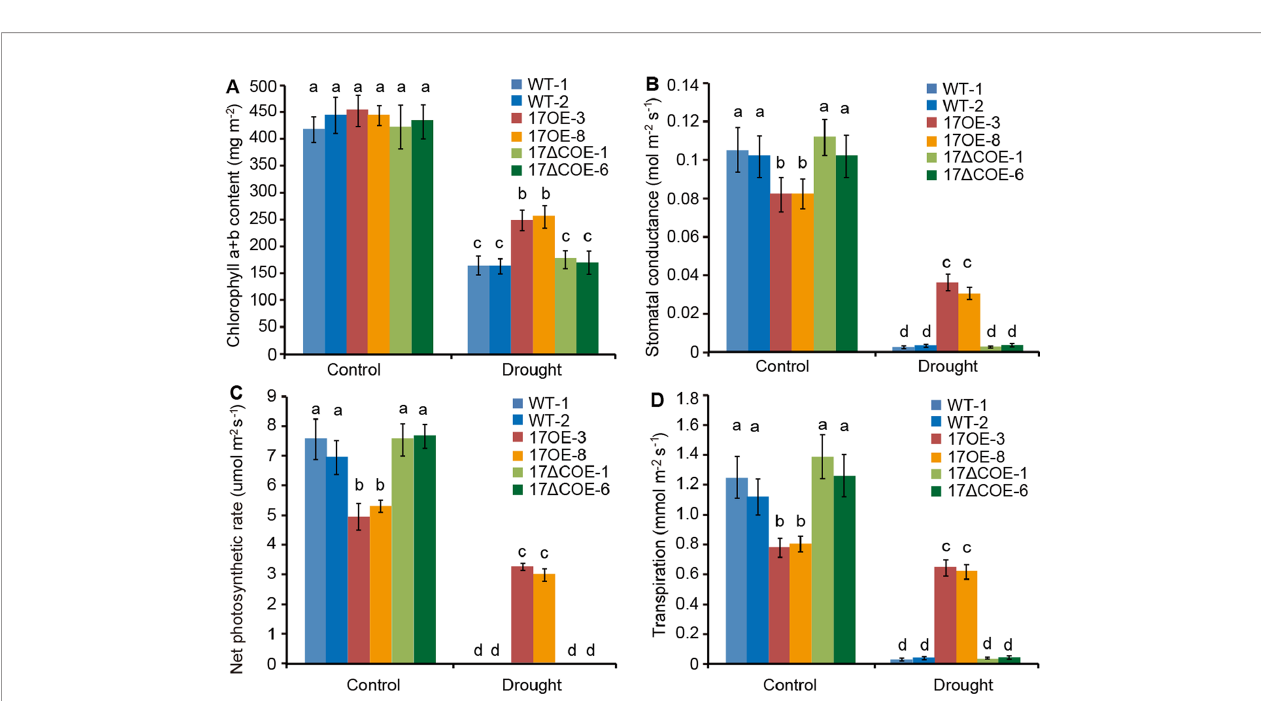
FIGURE 4 | Variation in photosynthetic parameters of 3-month-old Pd C3H17OE (17OE) and Pd C3H17 D COE (17 D COE) plants relative to those of WT plants after well-watered or drought stress conditions for 20 days. (A) Chlorophyll a+b content. (B) Stomatal conductance. (C) Net photosynthetic rate. (D) Transpiration. At least six plants of two lines in each genotype were measured. Data are presented as mean ± SD. Different letters above bars denote statistical signi fi cance between treatments of leaves ( P <